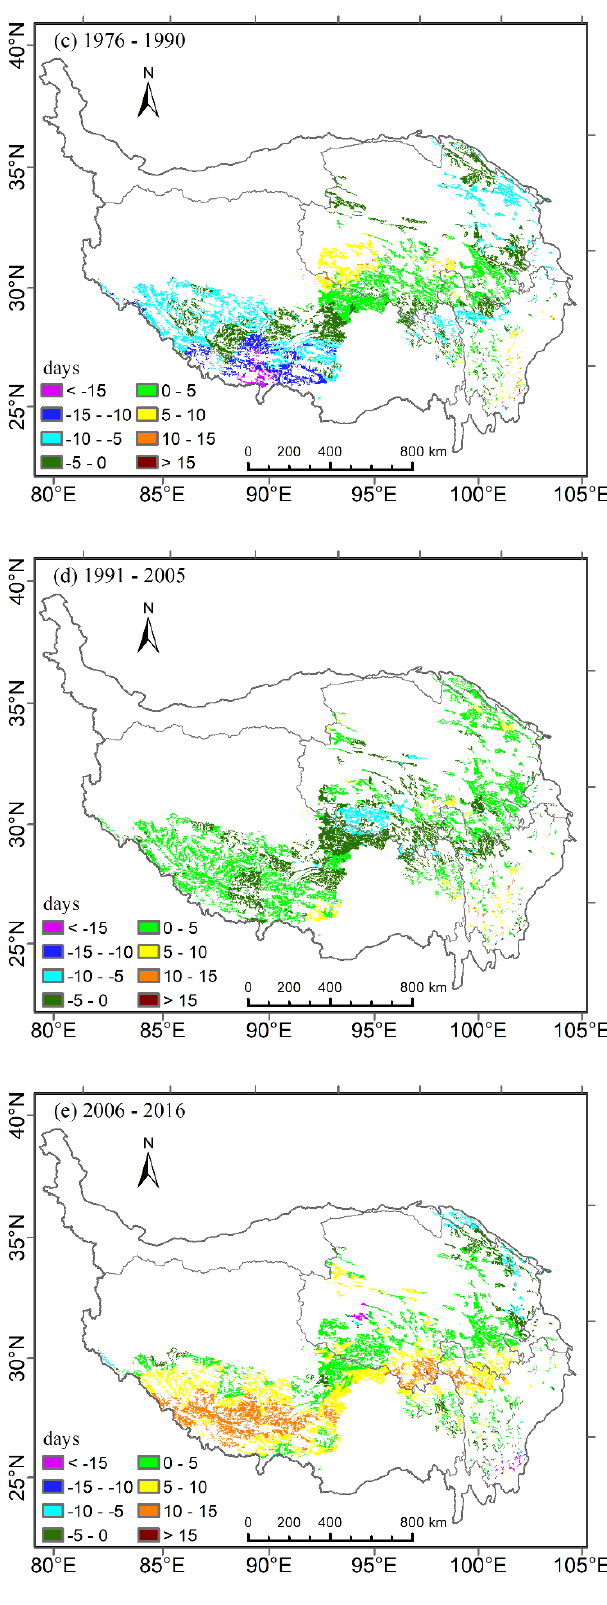
Figure 6. Spatial pattern of the temporal trends in the green-up date from 1961 to